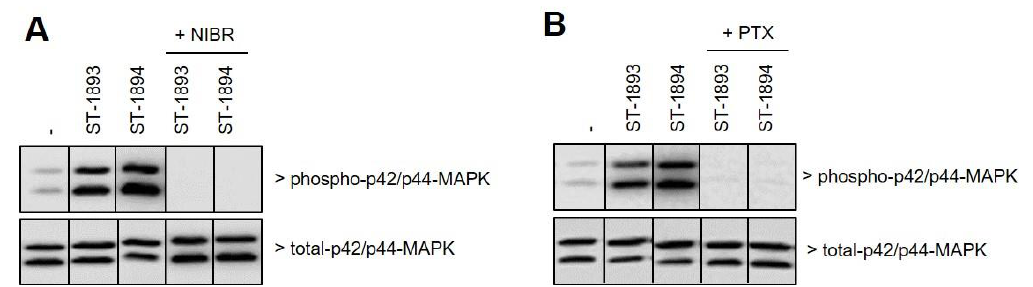
Figure 3. Effect of ST-1893 and ST-1894 on signaling downstream of S1P 1 . Starved confluent CHO-S1P 1 cells were pretreated for 15 min with NIBR-0213 (NIBR, 1 μM) ( A ) or for 18 h with pertussis toxin (PTX, 100 ng/mL) ( B ) prior to stimulation for 10 min with either vehicle (dimethyl sulfoxide (DMSO)) ST-1893, or ST-1894 (both at 3 μM). Protein extracts were prepared, separated by SDS-PAGE, transferred to nitrocellulose, and subjected to Western blot analysis as described in Section 4. Membranes were probed with phospho- and total-p42/p44-MAPK, and representative samples out of three independent experiments are shown.